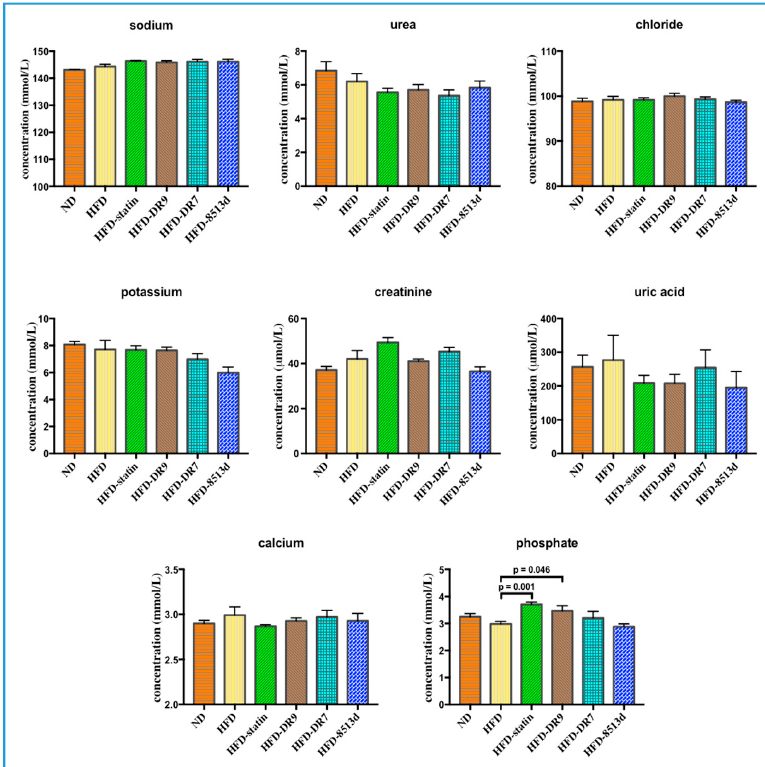
Figure 5. Renal function test, including sodium, urea, chloride, potassium, creatinine, uric acid, calcium, and phosphate of D-galactose-induced aging rats (600 mg/kg/day) after 12 weeks of treatment. ND (normal diet), HFD (high-fat diet), HFD-statin (high-fat diet, receiving lovastatin 2 mg / kg / day), HFD-DR9 (high-fat diet, receiving L. fermentum DR9 (10 10 CFU / day), HFD-DR7 (high-fat diet, receiving L. plantarum DR7 (10 10 CFU / day), HFD-8513d (high-fat diet, receiving L. reuteri 8513d (10 10 CFU / day). Results are expressed as mean; error bars (SEM); n = 6. Statistical analysis was performed using independent t -tests.